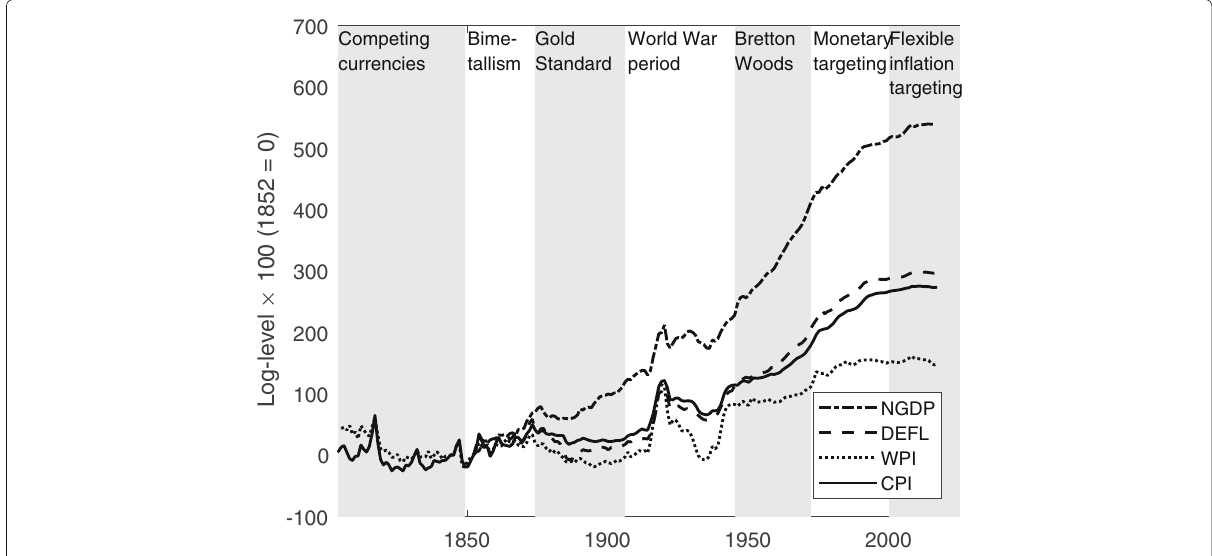
Fig. 1 Data. All series are shown in log-levels, multiplied by 100, and indexed to zero in 1852. The shaded and unshaded areas represent various monetary